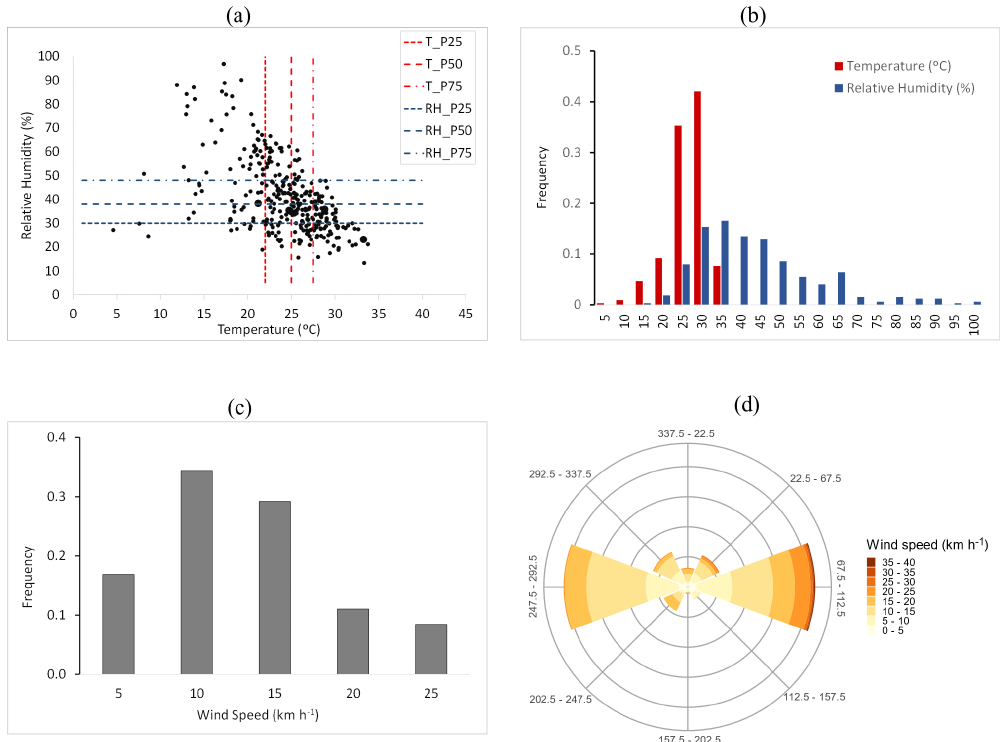
Figure A1. Fire weather variables compiled for the days of fire spread of the 200 wildfires from the fire database. (a) Average daily values of the variables were calculated for temperature and relative humidity, with quartile lines shown; (b) frequency distribution of T and RH; (c) frequency distribution of WS; and (d) wind rose. A total number of 326d was